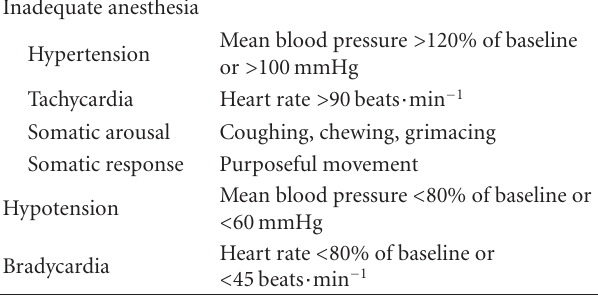
Table 1: Criteria for inadequate anaesthesia and hypotension or